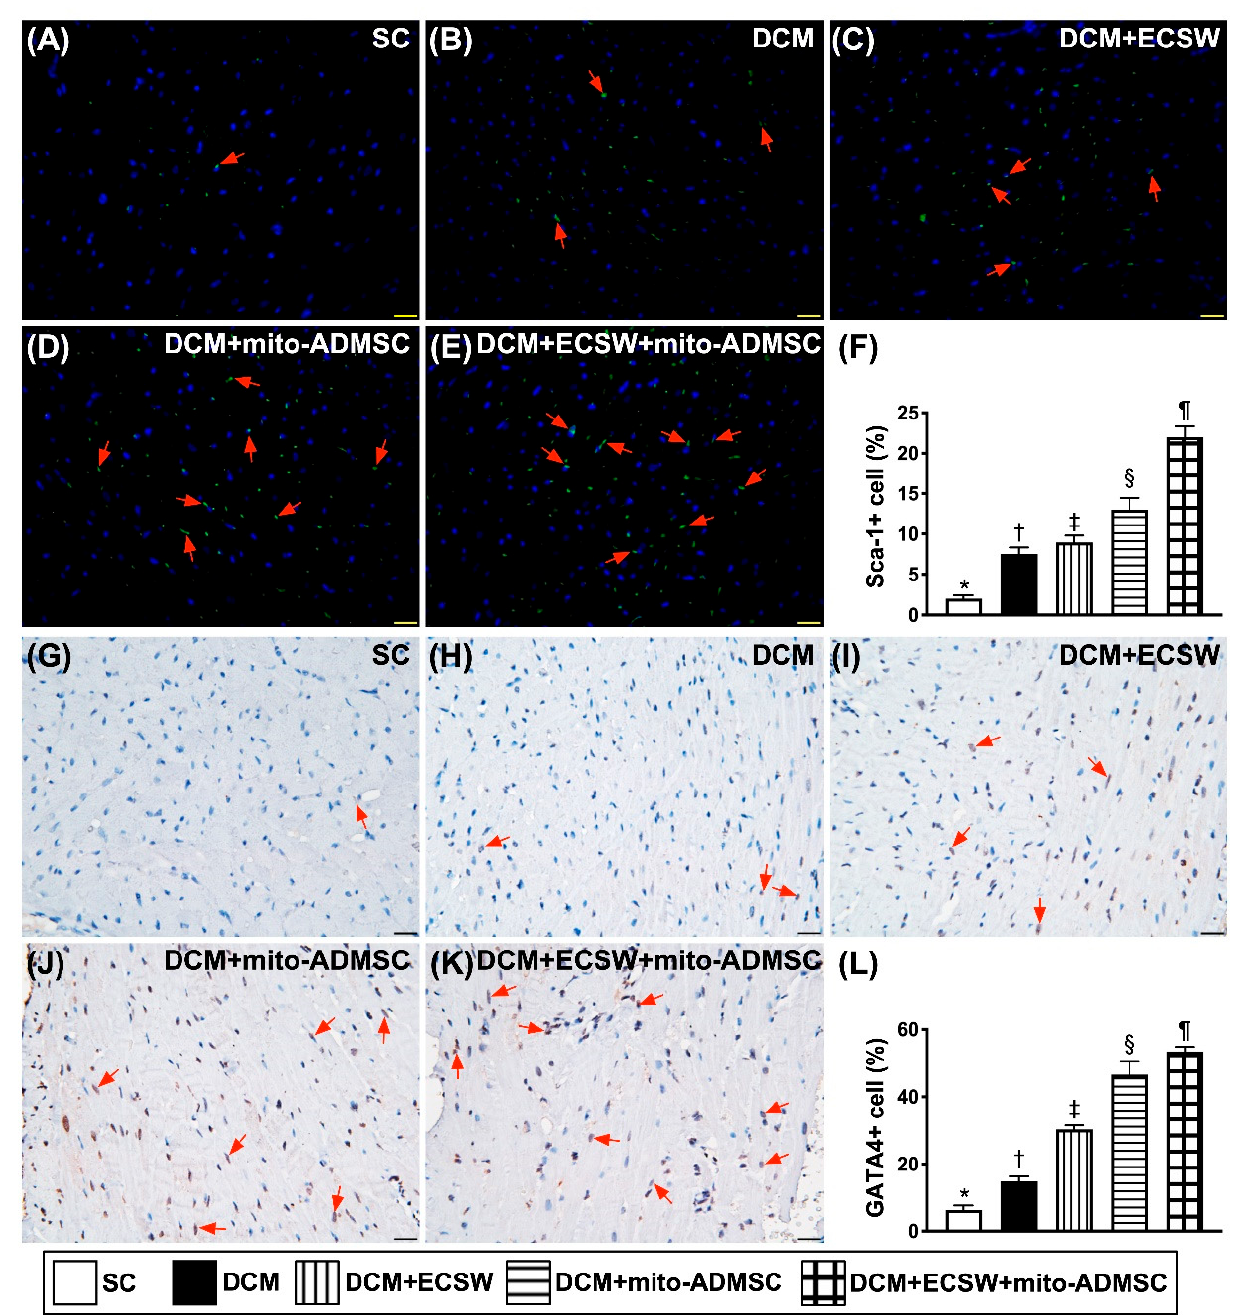
Figure 5. Cardiac stem cells and cardiac marker were upregulated by combined ECSW-assisted mitochondrial delivery into ADMSCs + ECSW therapy in LV myocardium 7 weeks after DCM induction. ( A – E ) Illustrating the microscopic finding (400 × ) for identification of cellular expression of Sca-1 (green color) (red arrows). ( F ) Analytical result of number of Sca-1+ cells, * vs. other groups with different symbols (†, ‡, §, ¶), p < 0.0001. ( G – K ) Illustrating the microscopic finding (400 × ) for identification of cellular expression of GATA4 (gray color) (red arrows). ( L ) Analytical result of number of GATA4 + cells, * vs. other groups with different symbols (†, ‡, §, ¶), p < 0.0001. Scale bar in right lower corner represents 20 µ m. All statistical analyses were performed by one-way ANOVA, followed by Bonferroni multiple comparison post hoc test ( n = 6 for each group). Symbols (*, †, ‡, ¶) indicate significance (at 0.05 level). ECSW = extracorporeal shock wave; SC = sham control; DCM = dilated cardiomyopathy; mito = mitochondria.